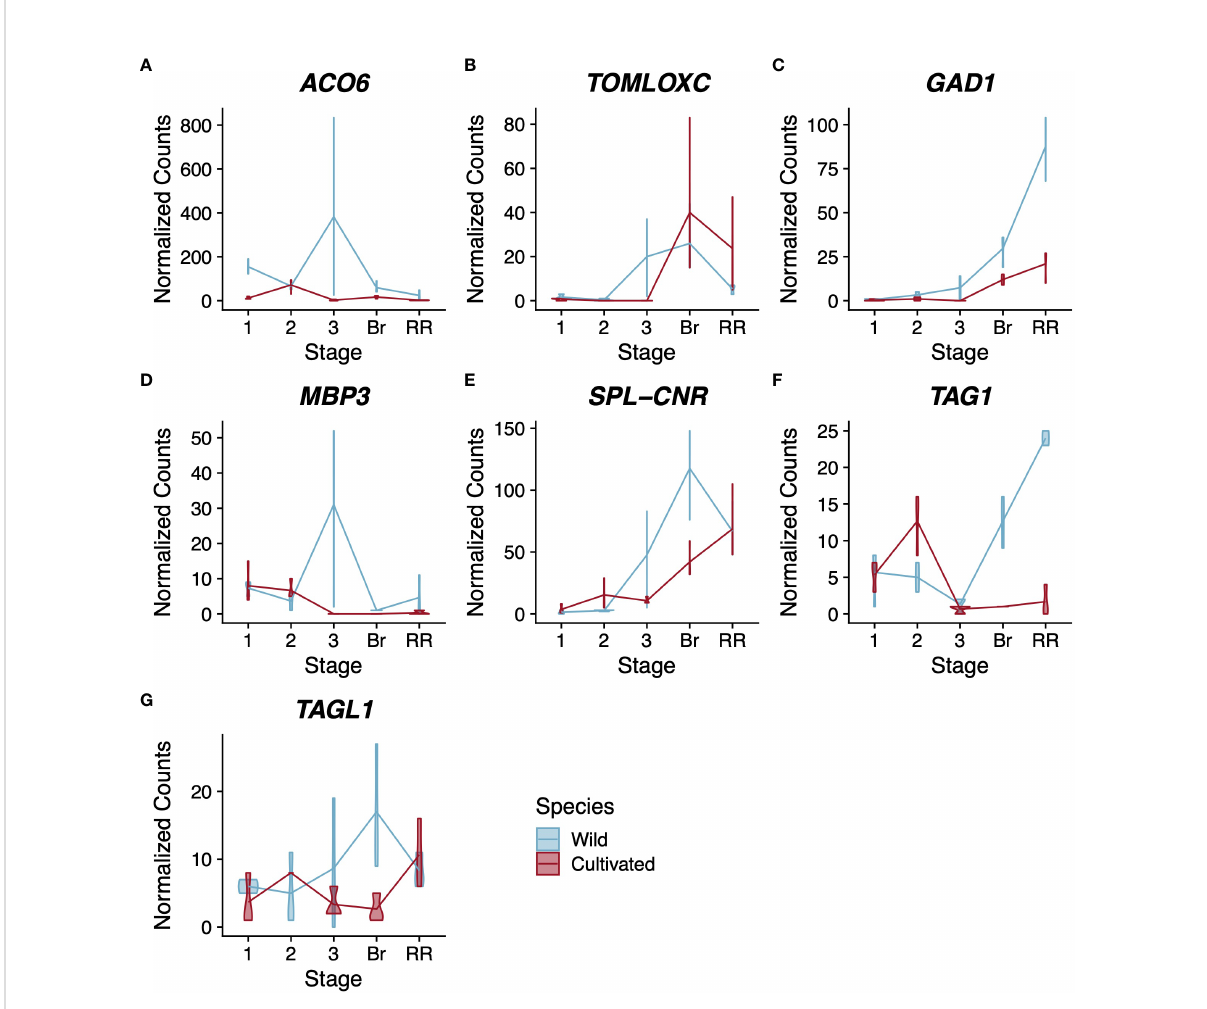
FIGURE 2 Expression pro fi les for ethylene-related (A) , fl avour compound-related (B – D) , and regulatory (D – G) genes. Normalised counts of gene expression are represented by violin plots. Genes with statistically signi fi cant (FDR<0.01) differential expression across stages are shown in bold. Wild tomato is shown in blue and cultivated in red. Stages of fruit development on the X-axis are numbered sequentially followed by “ Br ” for breaker stage and “ RR ” for red ripe stage Note that panels have independent Y-axis to maximise